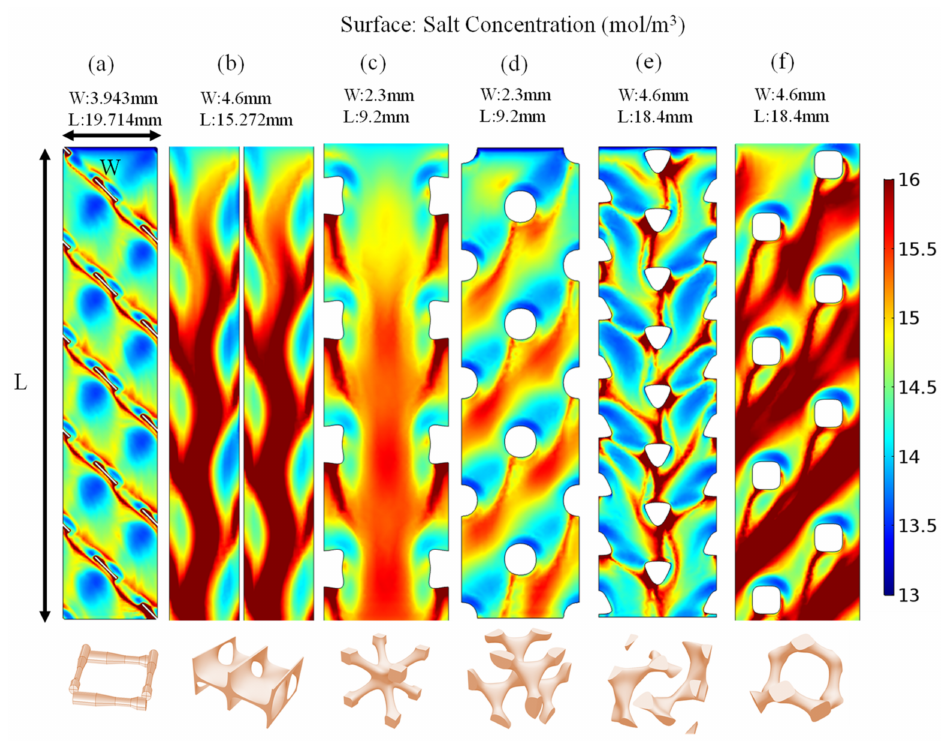
Figure 11. Contours of salt concentration (mol/m 3 ) on top membrane surface at u = 0.1 m/s in ( a ) commercial spacer-filled channel, ( b ) CLP spacer-filled channel, ( c ) IWP spacer-filled channel, ( d ) D spacer-filled channel, ( e ) L spacer-filled channel, and ( f ) IW spacer-filled